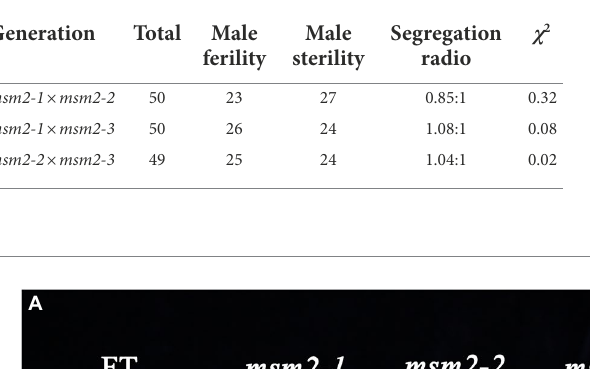
TABLE 2 Analysis for allelism test of the mutants msm2-1/2/3.